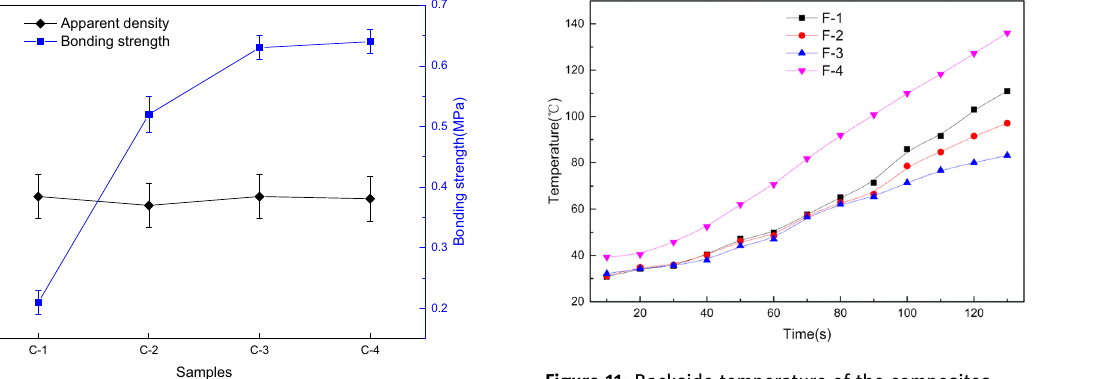
Figure 11: Backside temperature of the